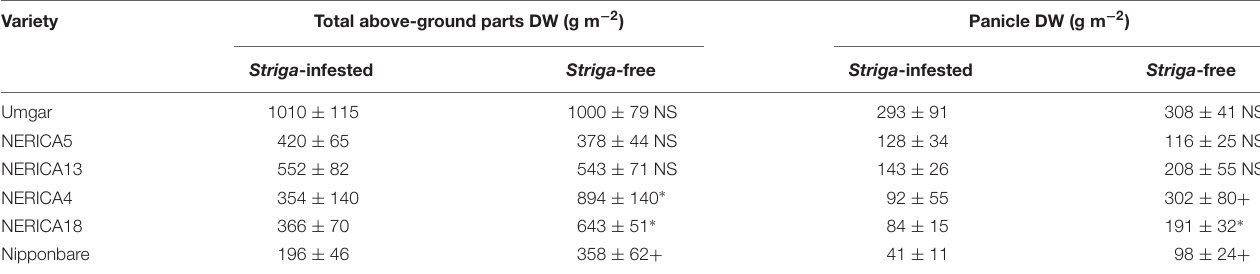
Data are mean ± standard error of four replications. ∗ and + indicate significant differences at p < 0.05 and 0.10, respectively, by Student t-test within a variety. NS indicates not significant (p > 0.10) within a variety.